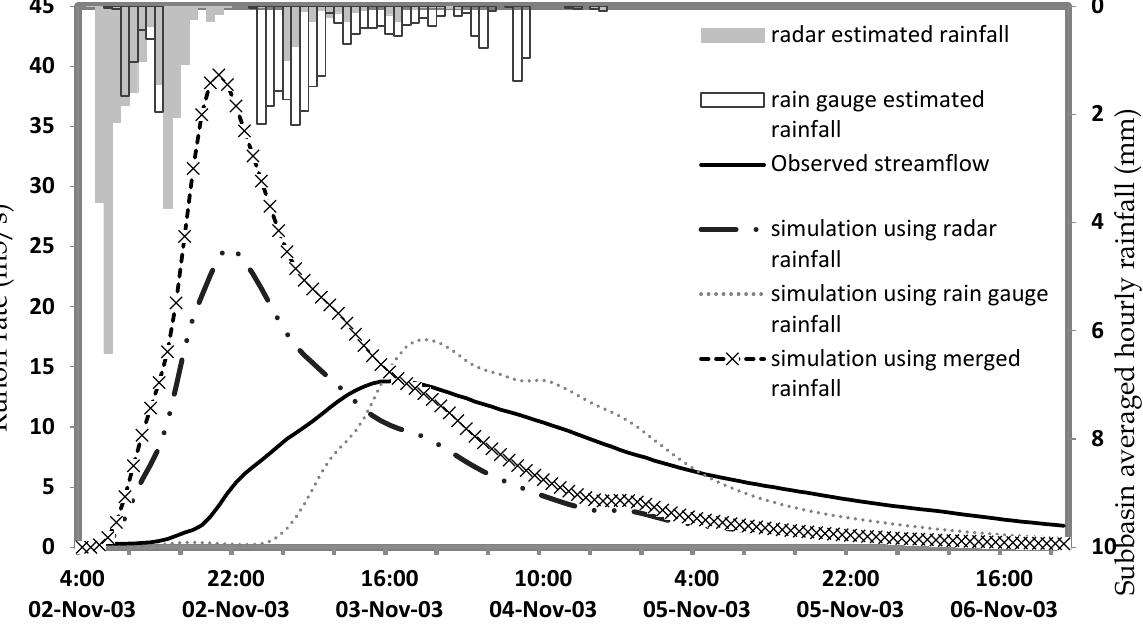
Figure 17. Comparison of estimated and observed hydrographs using different rainfall estimates for the 20 May 2004 event with SCS modeling option.